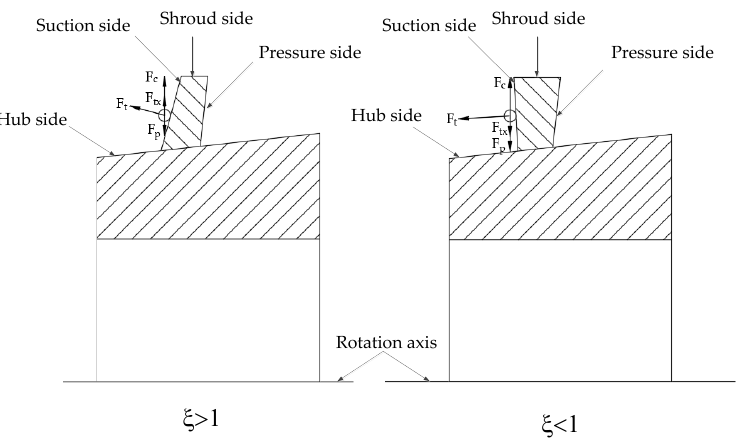
Figure 14. Schematic diagram of force on fluid particles in the axial section of the impeller.